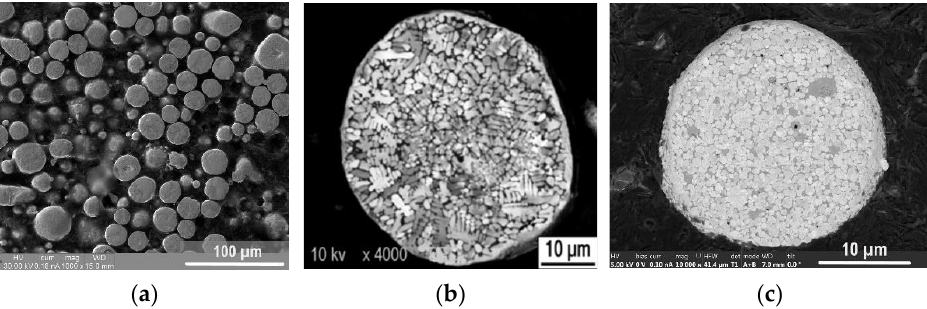
Figure 6. Cross-section of plasma-treated W-5Ni-2Fe micropowder (SEM images) after mechanical grinding ( a ) and cross-section of the individual particles ( b , c ). The W-Ni-Fe micropowder, obtained by processing nanopowder microgranules in a hydrogen-containing plasma jet, contains 0.7 wt. % of oxygen, 0.005 wt. % of nitrogen, and 0.0001 wt. % of hydrogen. The powder bulk density is 8.9 g/cm 3 and the powder flow rate is 10 s (Hall flowmeter, 50 g). The phase composition of W-Ni-Fe micropowder is characterized by the presence of the main phase W and slight phases of Fe 0.95 W 0.05 and Ni 8.11 W 1.89 (Figure 7).